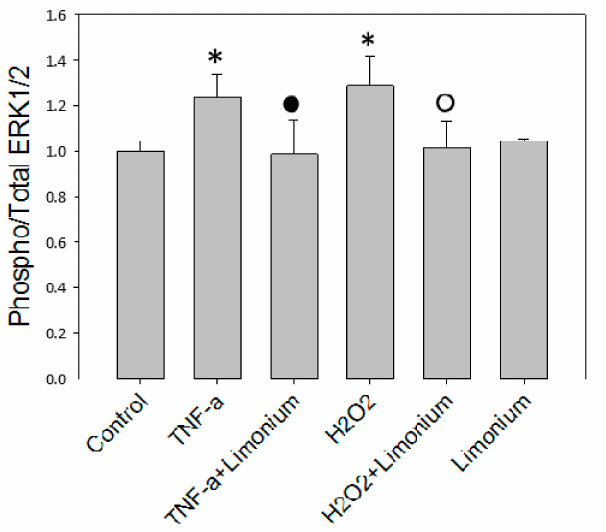
Figure 5. L. gmelinii extract suppresses activation of ERK 1/2 kinase induced by TNF- α in